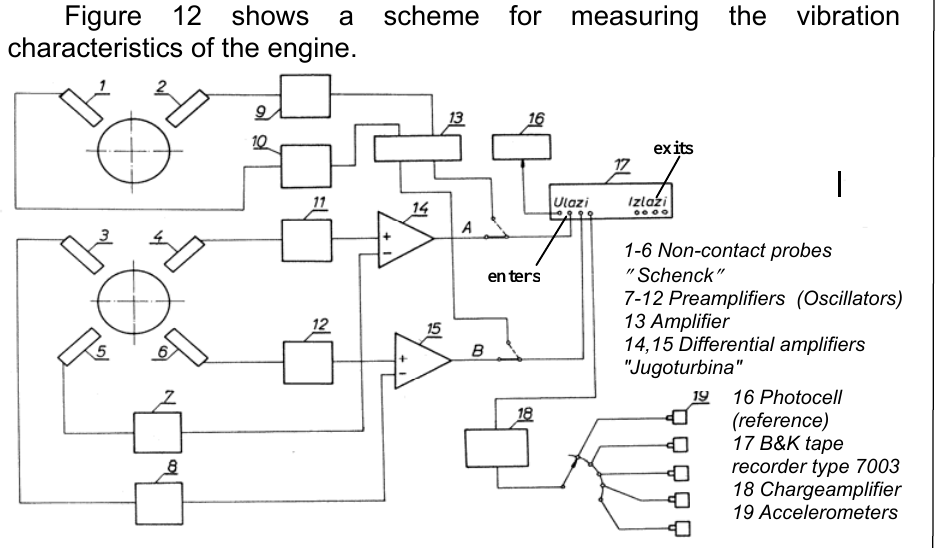
Figure 12 - Scheme of measuring the vibration characteristics of the engine 6ASL -25D Рисунок 12 - Схема измерения вибрационных характеристик двигателя 6ASL-25D Слика 12 - Шема мерења вибрацијских карактеристика мотора 6ASL